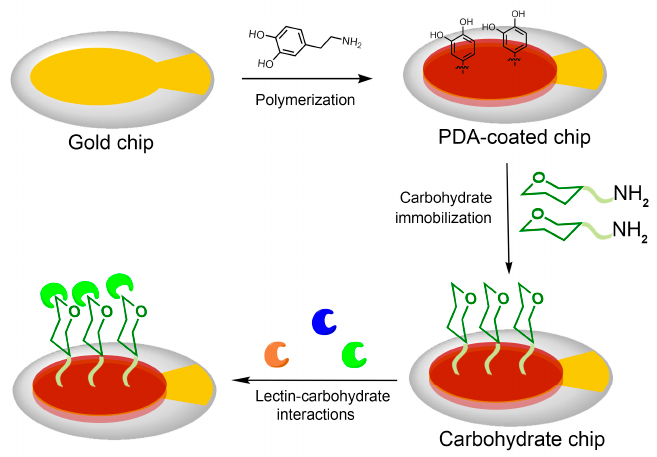
Figure 2. Schematic illustration of carbohydrate chip fabrication and interaction with lectins.